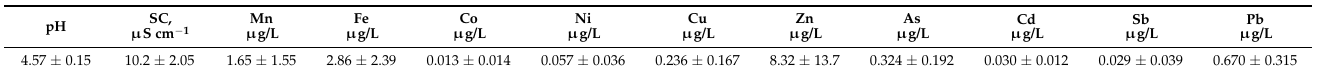
Table 1. Physicochemical properties of dissolved (<0.22 µ m) fraction of the snow water and